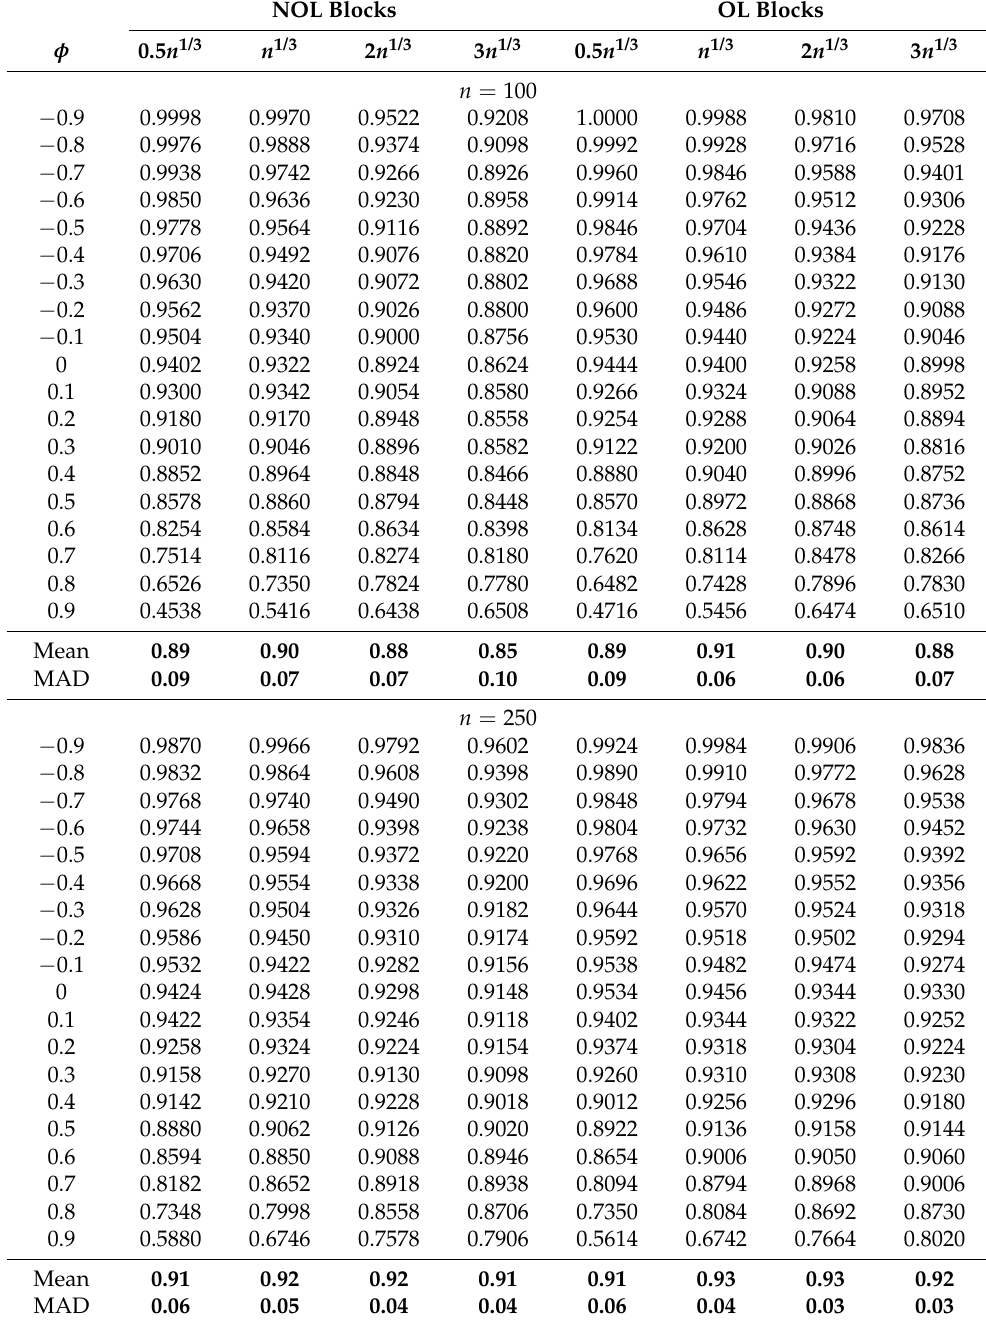
Table 1. Coverage probabilities for 95% BEL CIs for the mean of X t = φ X t − 1 + (cid:101) t ( (cid:101) t i.i.d. standard normal), with n = 100,250 for NOL and OL blocks of size b = Cn 1/3 using 5000 simulations. Means and mean average deviations (from 0.95) of coverage probabilities are indicated in